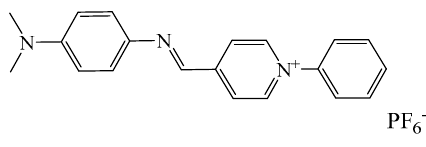
Figure 13. Molecular structure of ionic salt with Schiff base structure.